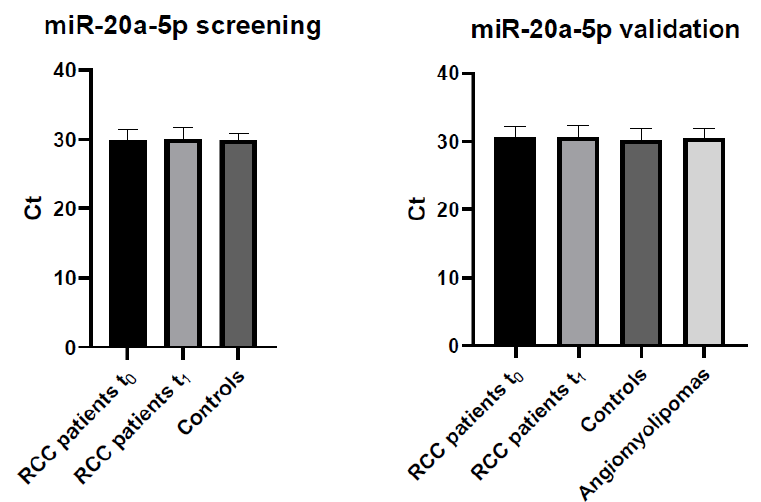
Figure 3. Differences in expression levels of the candidate miRNA normalizer miR-20a-5p selected by the comprehensive ranking of RefFinder between RCC patients and controls. Expression levels are represented as Ct values and error bars represent standard deviation. ANOVA p > 0.05.